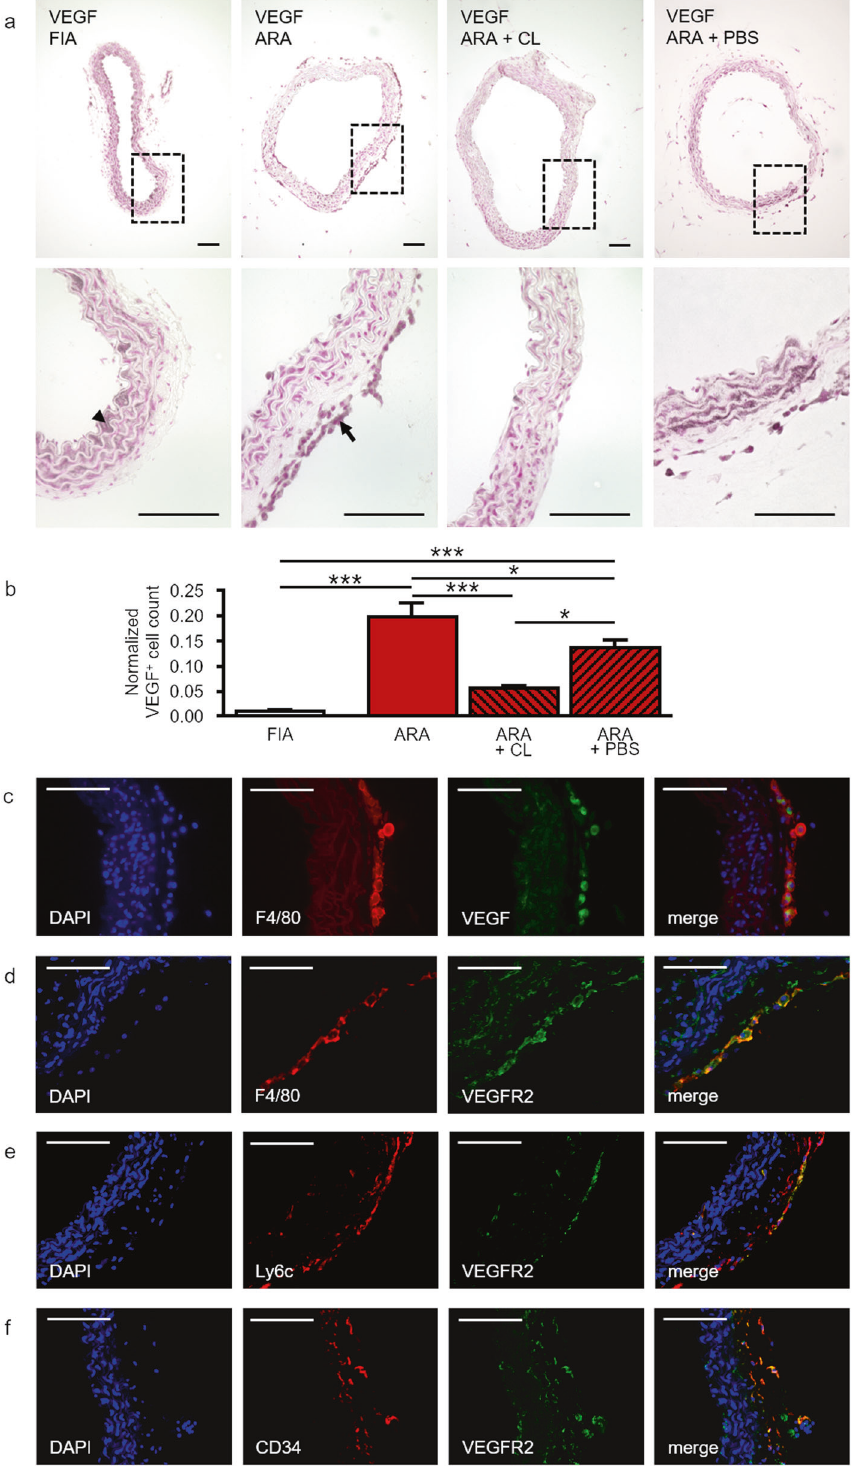
Fig. 5 Expression of VEGF/ VEGFR2 in macrophages and CD34 + progenitor cells in ARA. a Cross-sections of murine aortae were immunostained for the pro-angiogenic factor VEGF. In FIA, VEGF is predominantly expressed by intimal cells (arrowhead) and cells within the media. In ARA the number of VEGF + cells increased substantially especially within the adventitia (arrow). This increase was largely prevented by the depletion of macrophages. b Statistical analysis of the number of adventitial VEGF + cells with and without liposome treatment. Cell counts were normalized to total media area ( n = 6 – 8). c Cross-sections of cultured aortic rings were analyzed by confocal co-immuno fl uorescence for the presence of VEGF + and F4/80 + cells, respectively. Almost all adventitial cells that were highly positive for VEGF co-express F4/80. d Additionally, F4/80 + cells in cross-sections of cultured aortic rings co-express VEGFR2. e , f Similarly, in cross-sections of FIA Ly6c + and CD34 + progenitor cells show at least partially co-expression of VEGFR2 by confocal immuno fl uorescence microscopy. * P <0.05; *** P <0.001. Scale bars: 100µm. FIA fresh isolated aorta, ARA aortic ring assay, ARA + CL ARA with clodronate-containing liposomes, ARA + PBS ARA with PBS-containing liposomes. Cell Death and Disease (2022)